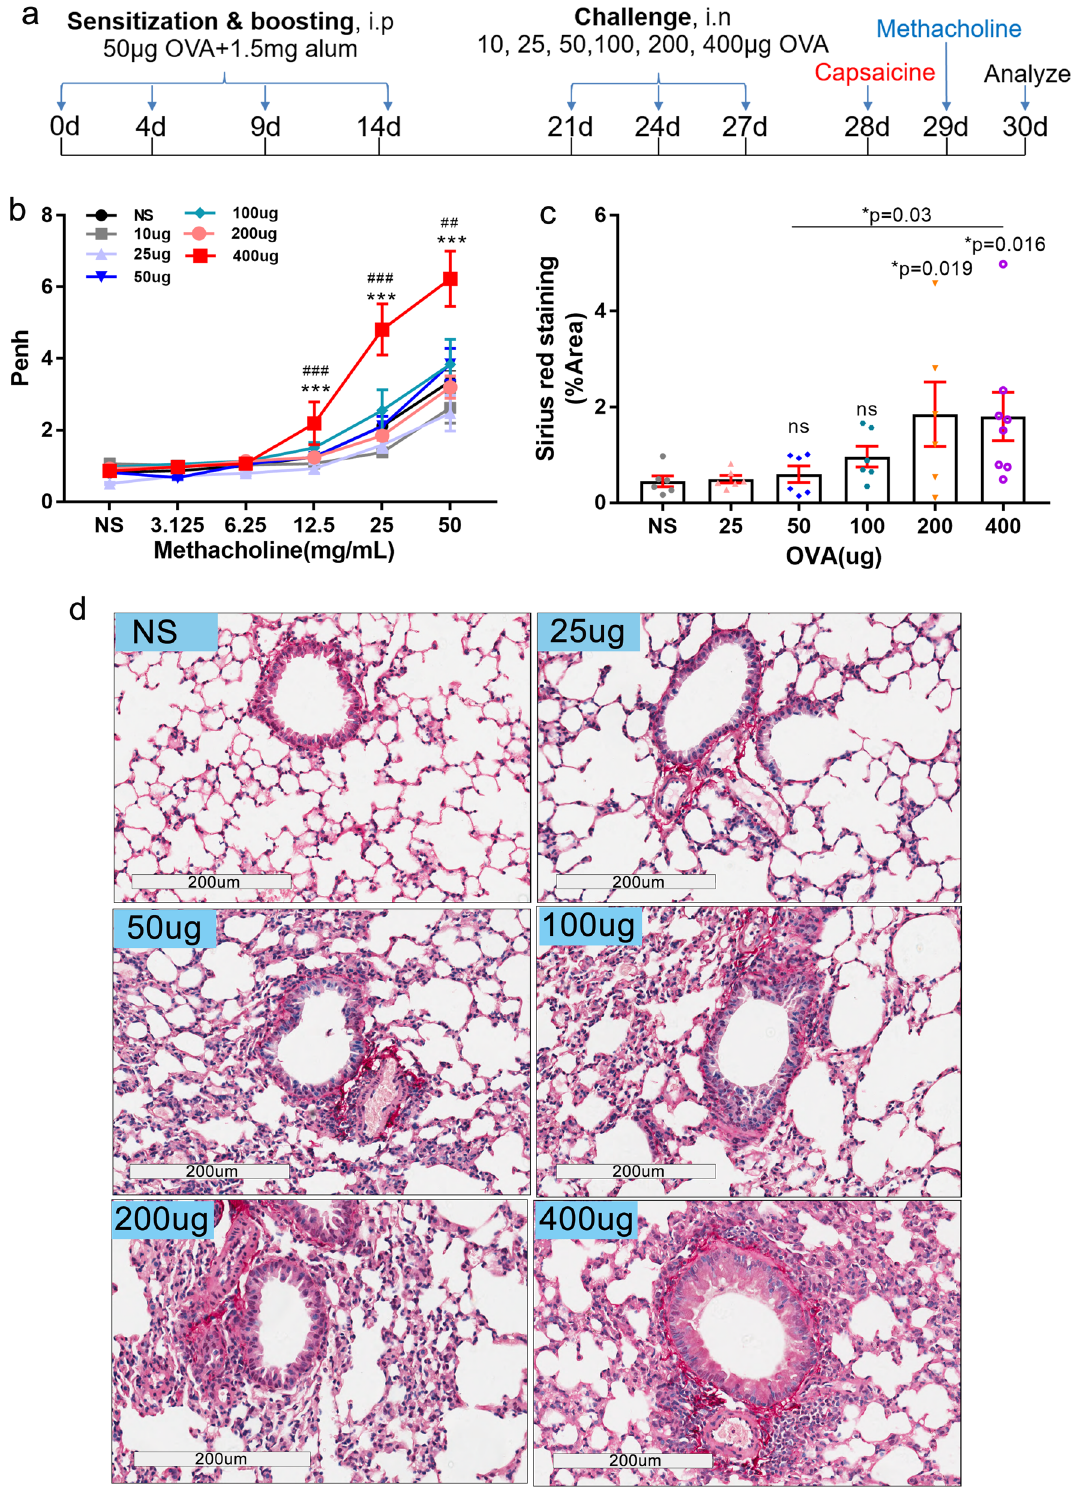
Figure 1. Flow chart of EB model establishment using C57BL/6 mice, lung resistance and collagen deposition measurements. ( a ) Flow chart of EB model establishment using C57BL/6 mice. C57BL/6 mice were sensitized and then boosted with ovalbumin (OVA) plus aluminium adjuvant (alum) intraperitoneally and then intranasally challenged with OVA three times. 12 h after the last challenge, the capsaicine-induced cough frequency was recorded. 36 h after the last challenge, lung resistance or lung enhanced pause (Penh) was evaluated, and finally BALF and lung tissues were subsequently harvested for further analyses. ( b ) Penh in all groups changes in response to increased doses of inhaled methacholine (MCh) (3.125, 6.25, 12.5, 25, and 50 mg/mL). ( c , d ) Different doses of OVA challenge affected collagen deposition in lung tissue of mice, as revealed by Sirius red staining. With NS challenge and different doses of OVA challenge, semi-quantitative image analysis of the collagen deposition area ( c ) and representative views ( d ) are shown [25 µg OVA dose, n = 5, other groups, n ≥ 9. * P ≤ 0.05; ** P < 0.01; *** P < 0.001; ns, no significance; ## P < 0.01. *compared with NS, # compared with 50 µg]. The scale is indicated on the panel by the length of the box around the size in